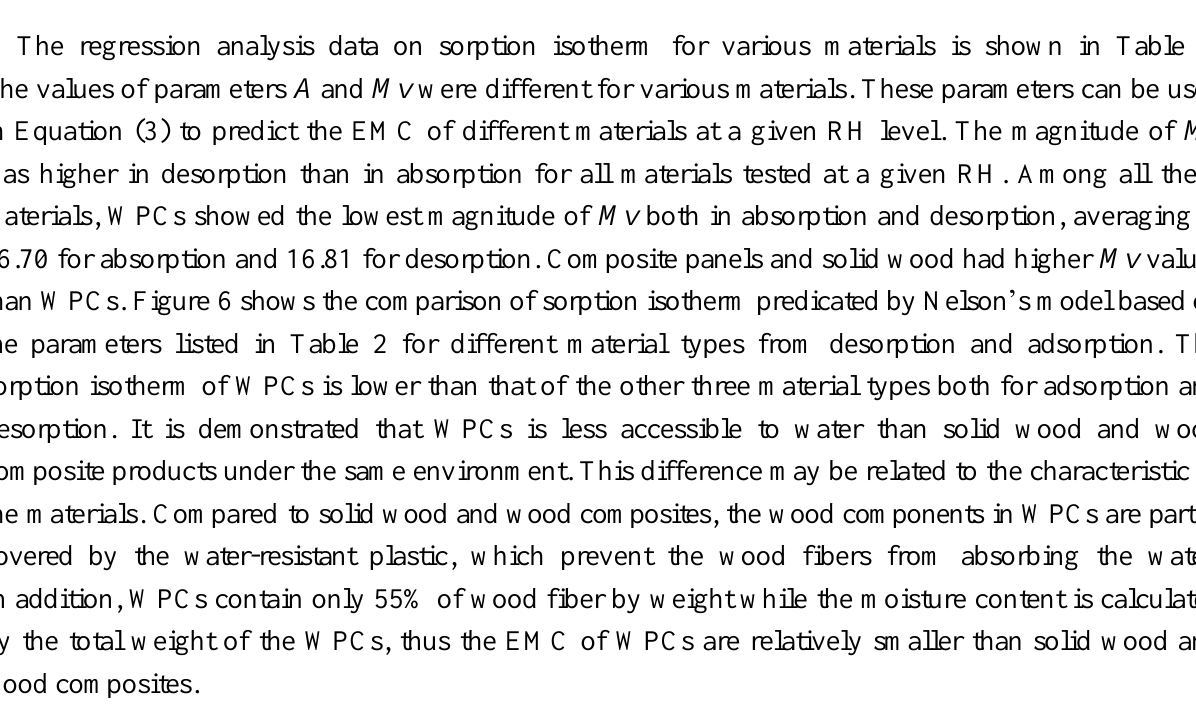
Figure 5. Comparison between calculated EMC by Nelson’s model and measured EMC from experiments. Lines show values predicated by the model.